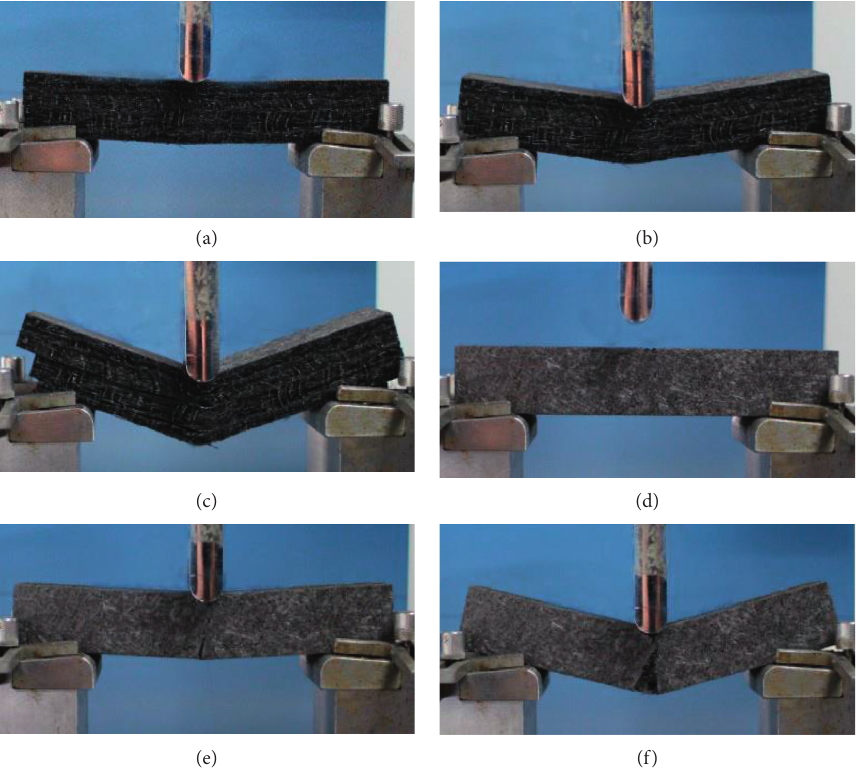
Figure 15: Bending failure process diagrams of carbon/carbon fiber composites: (a), (b), and (c) front bending ( Z direction); (d), (e), and (f) side bending ( X direction or Y